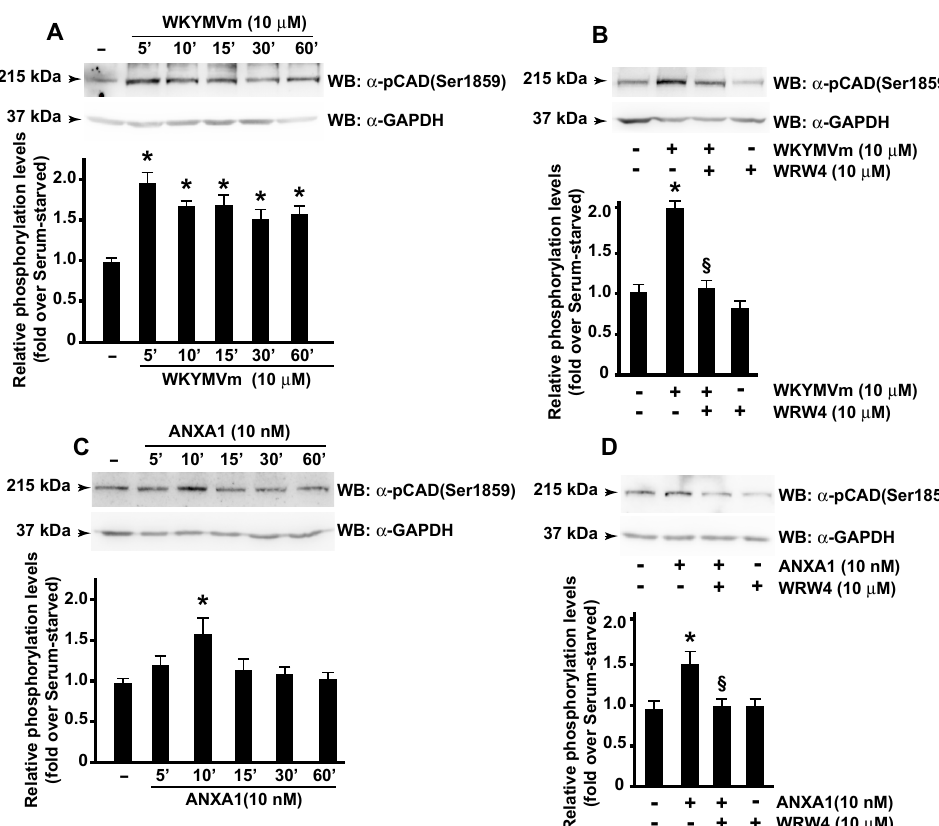
Figure 5. FPR2 signaling elicits CAD activation. Serum-deprived CaLu-6 cells were exposed for the indicated times to WKYMVm (Panel A ) or ANXA1 (Panel C ). Growth-arrested cells were also preincubated with WRW4 before WKYMVm (Panel B ) or ANXA1 (Panel D ) stimulation. Sixty micrograms of whole lysates were resolved on 10% SDS-PAGE and incubated with an anti-phospho-CAD (Ser1859) ( α -p-CAD (Ser1859)) antibody. An anti-GAPDH ( α -GAPDH) antibody was used as a control for protein loading. Data are representative of three independent experiments. * p < 0.05 compared to unstimulated cells. § p < 0.05 compared to stimulated cells.